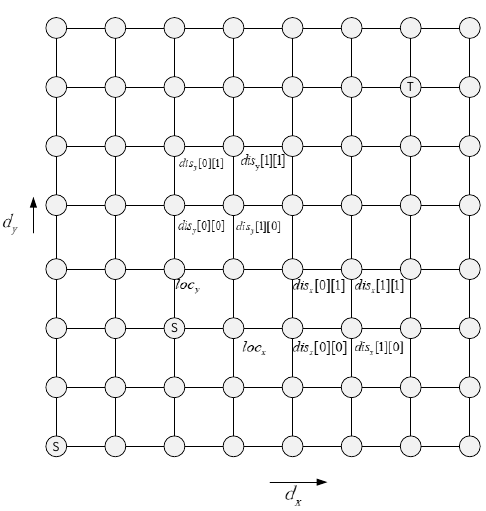
Figure 4. Parameters corresponding to Algorithm 2.